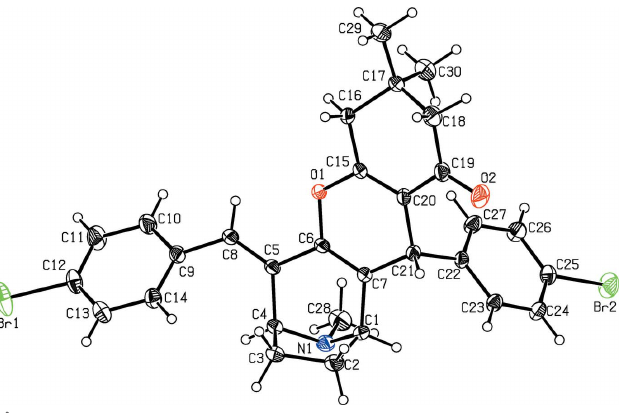
Figure 3 Superposition of compound (I) (violet) and compound (II) (brown) except for atoms Br1, Br2 and